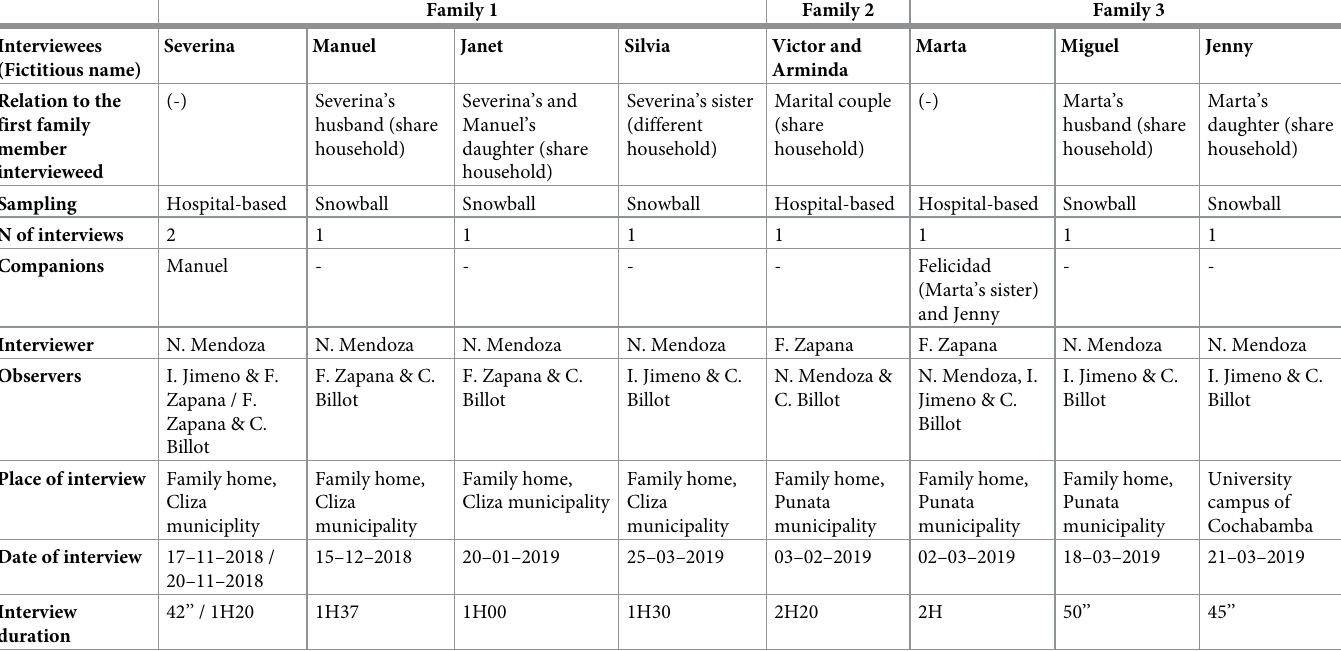
Table 1. Complementary information about the in-depth interviews